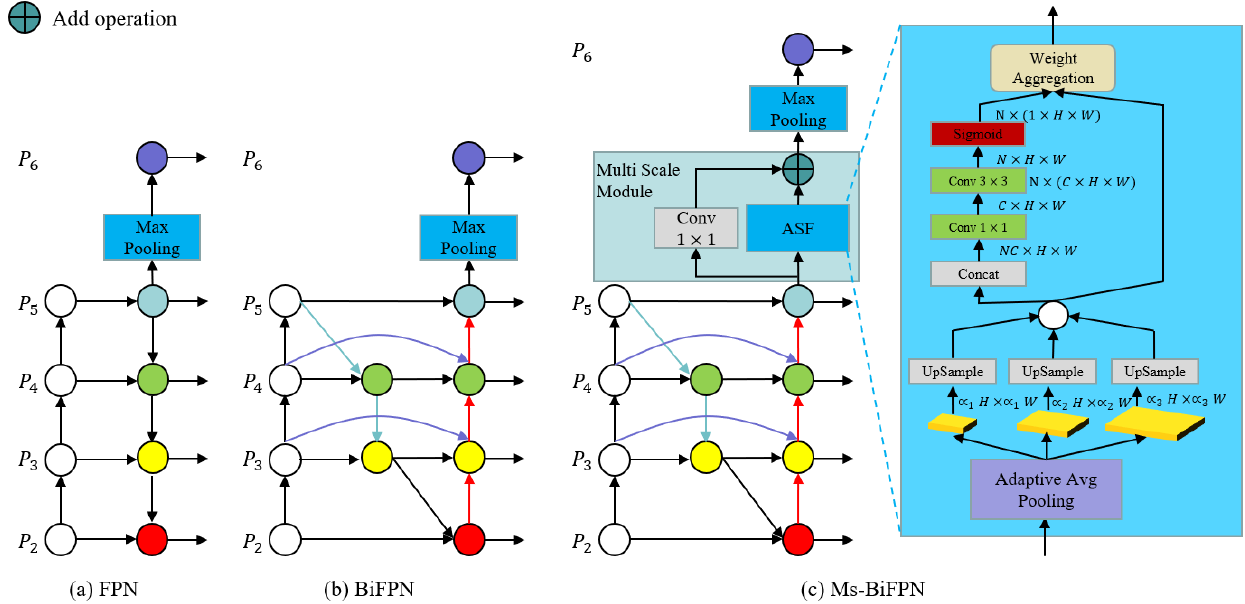
Figure 6. The architecture of FPN, BiFPN and Ms-BiFPN. ∝ 1 , ∝ 2 and ∝ 3 represent the coefficients of adaptive pooling, and the values are 0.1, 0.2 and 0.3, respectively, in this paper. N represents the number of scale factors used in adaptive pooling, and the value is 3.